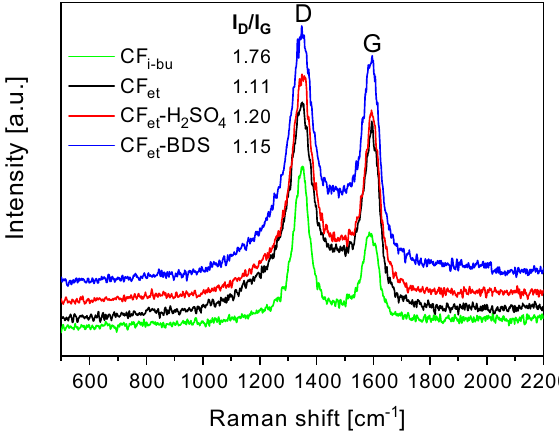
Figure 4. Raman spectra of selected samples.